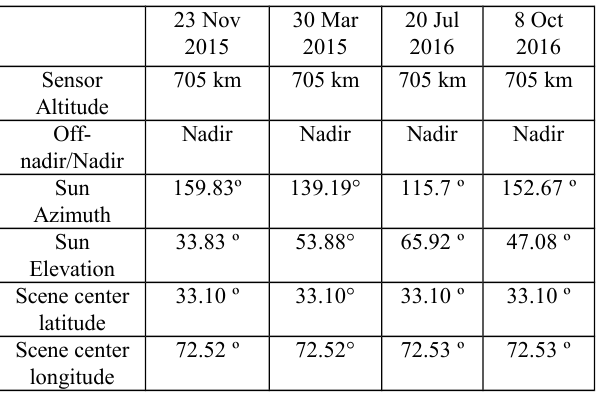
Table 1 : Imaging geometry conditions and scene center latitudes and longitudes for Landsat-8